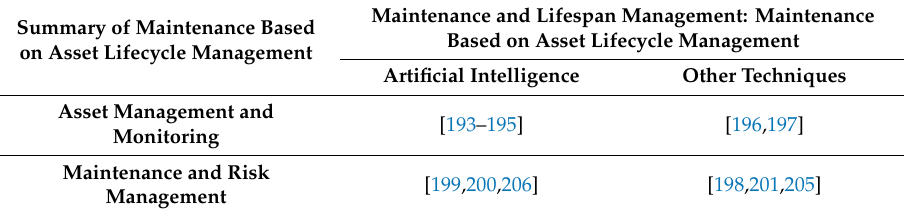
Table 8. Summary of Maintenance based on Asset Lifecycle Management. Summary of Maintenance Based on Asset Lifecycle